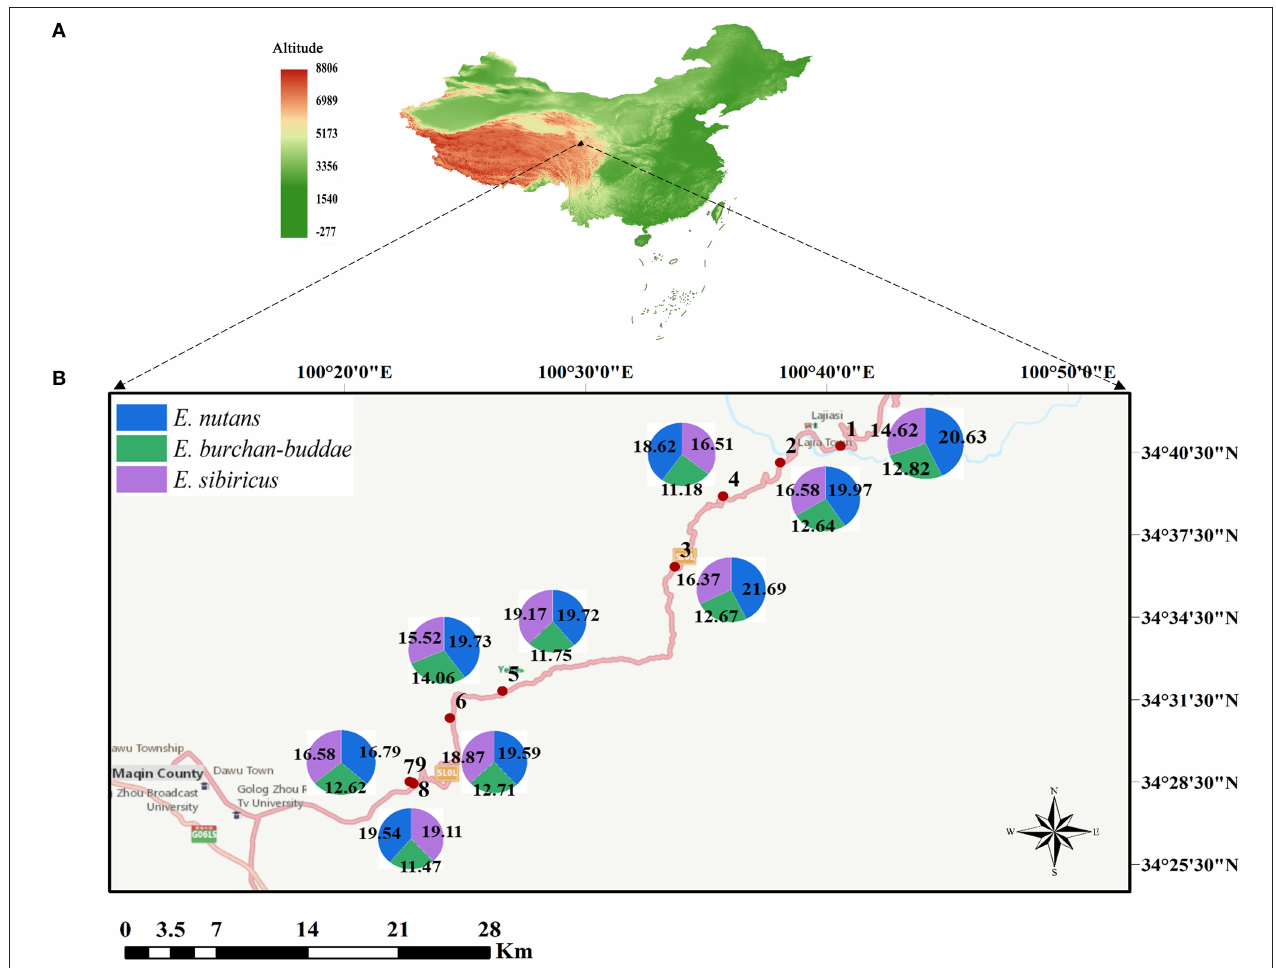
FIGURE 1 | Geographical distribution of the nine sampling sites and genome size of three Elymus species ( E. nutans , E. burchan-buddae , and E. sibiricus , the detailed altitudes are given in Supplementary Table 1 ). (A) Sampling location at the Qinghai–Tibetan Plateau center of China. (B) The geographical location of the population sampled. The crook lines indicate various sizes of national highways; the pizza charts show the genome size of three Elymus species; and the numbers in the charts represent the population